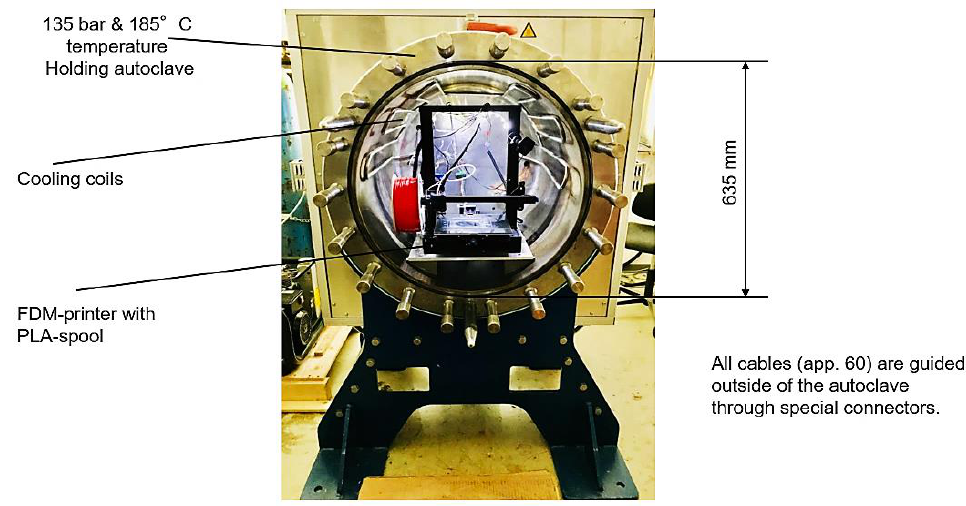
Figure 3. 3D Printer setup in the